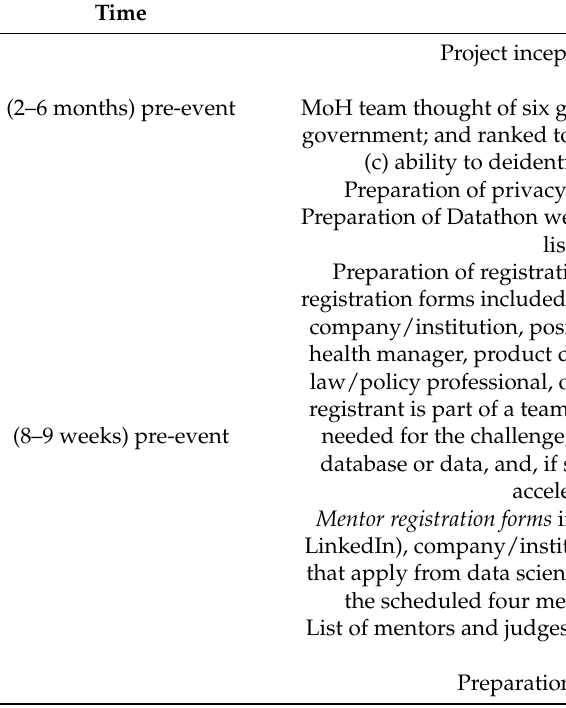
Table 2. Steps in the Datathon organization (and responsible partners). Recommended new steps and changes based on lessons learned are shown with ** in front of them.